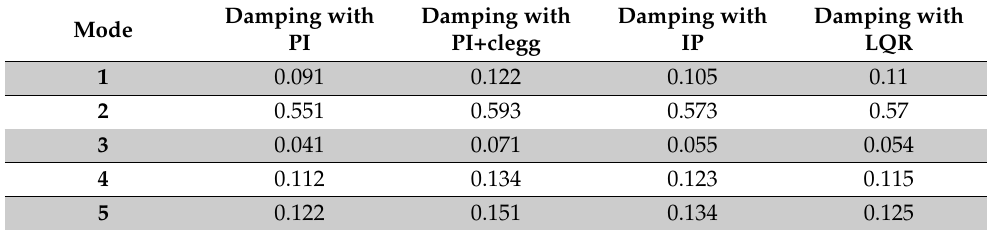
Table 8. Damping performance of complete system under different